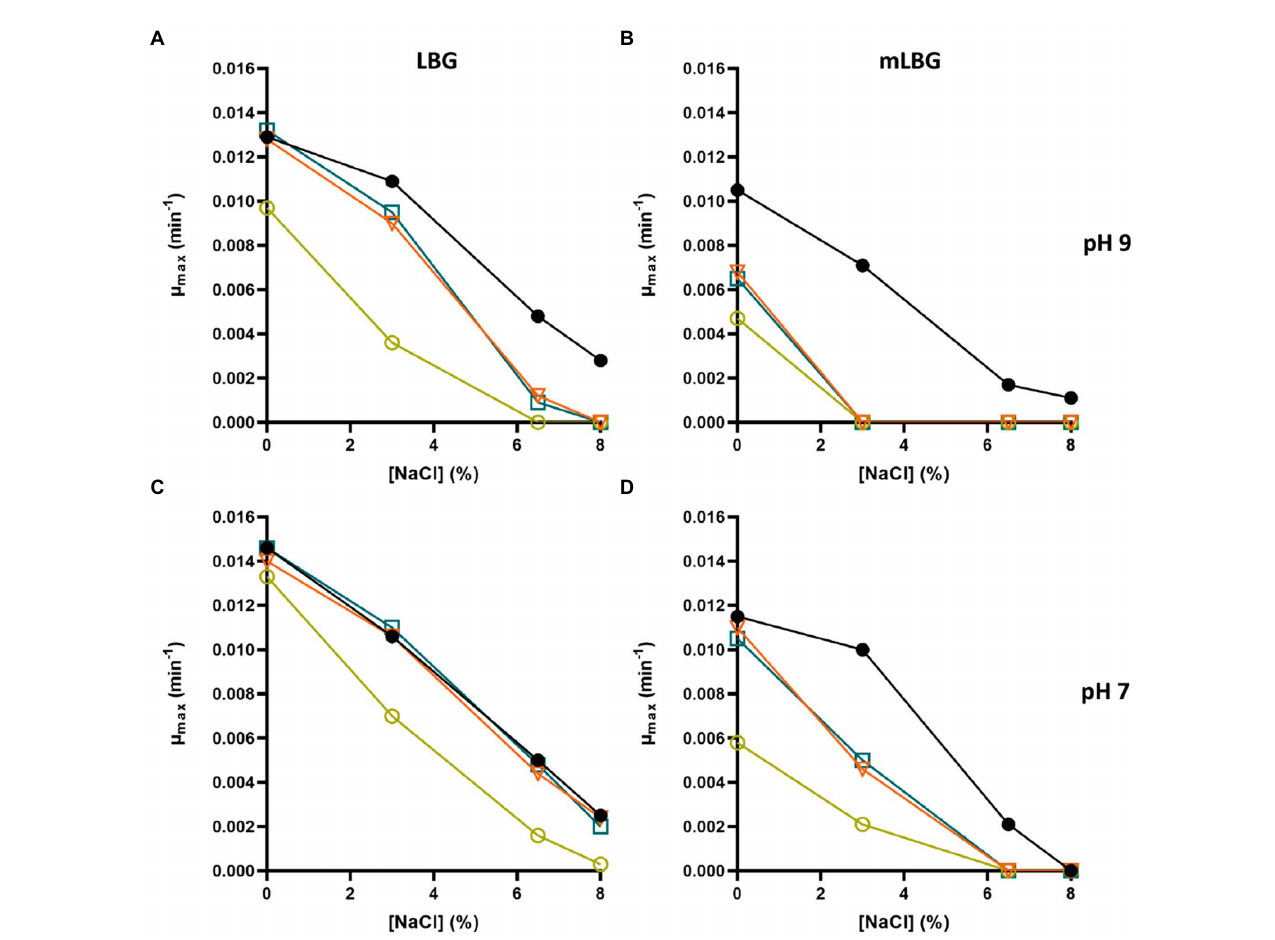
FIGURE 4 Inhibition of growth rate of Enterococcus faecalis JH2-2 mutants by NaCl. Wild type (black dot), Δ ktrA (light blue square), Δ kup Δ ktrA (yellow circle), and Δ ktimA Δ ktrA (orange triangle) strains were grown in LBG (A,C) and mLBG medium (B,D) at initial pH 9.0 (top) or 7.0 (low) in the presence of increasing concentrations of